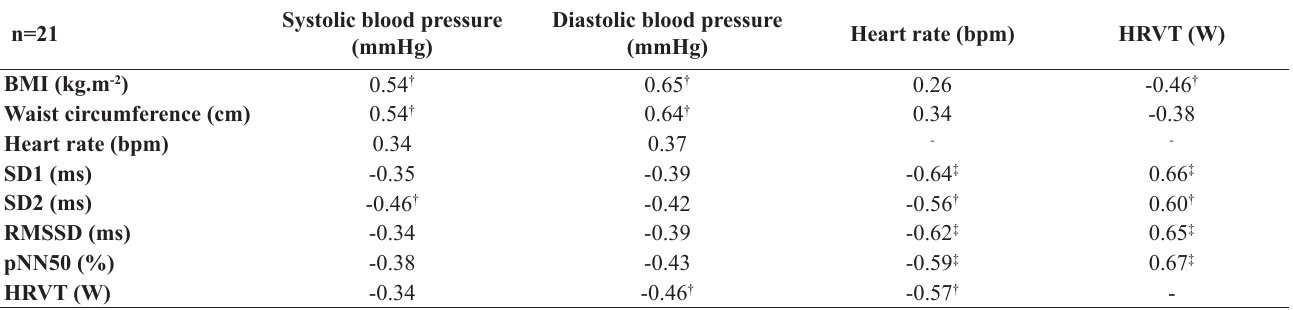
Table 3. Correlation coefficients (r) between anthropometric variables, blood pressure, heart rate variability indexes at rest and heart rate vari- ability threshold (HRVT).